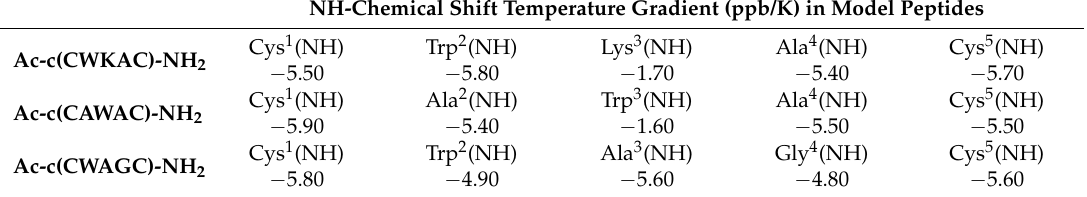
Table 3. Temperature-dependent 1 H-NMR measurements of the studied peptides, providing the chemical shift gradients of amide